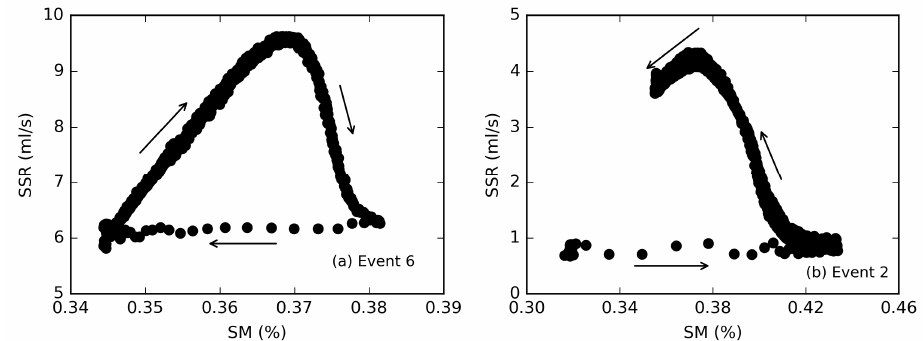
Figure 12. Hysteretic behavior in SSR (Subsurface runoff) with the respect to the SM (soil moisture) 30 cm during ( a ) an event with wet condition and ( b ) an event with dry at 30 cm during ( a ) an event with wet condition and ( b ) an event with dry condition.